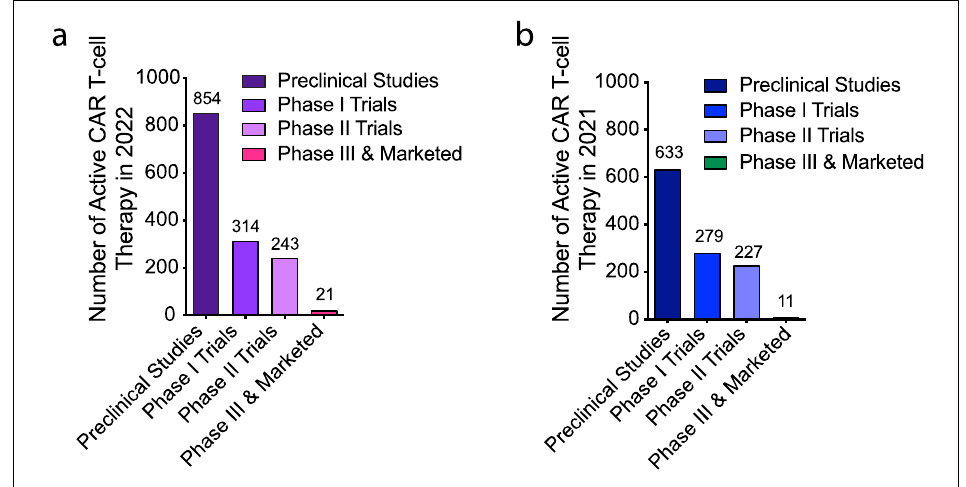
Figure 2. Active CAR T-cell therapies developed in 2022 and 2021. ( a ) A total of 1432 active CAR T-cell therapies have been developed in 2022, including preclinical research (854), phase I (314), phase II (243), phase III and market trials of 21. ( b ) A total of 1150 active CAR T-cell therapies were developed in 2021, including 633 preclinical research, 279 phase I, 227 phase II, 11 phase III and market trials.